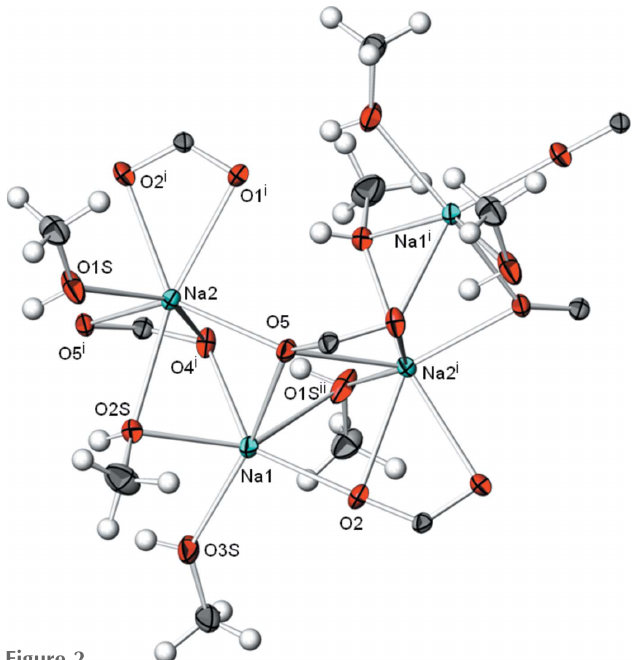
Figure 2 Part of the crystal structure of (I) emphasizing the coordination environments of the two Na + cations. Displacement ellipsoids are drawn at the 50% probability level. Symmetry codes refer to Table 1.